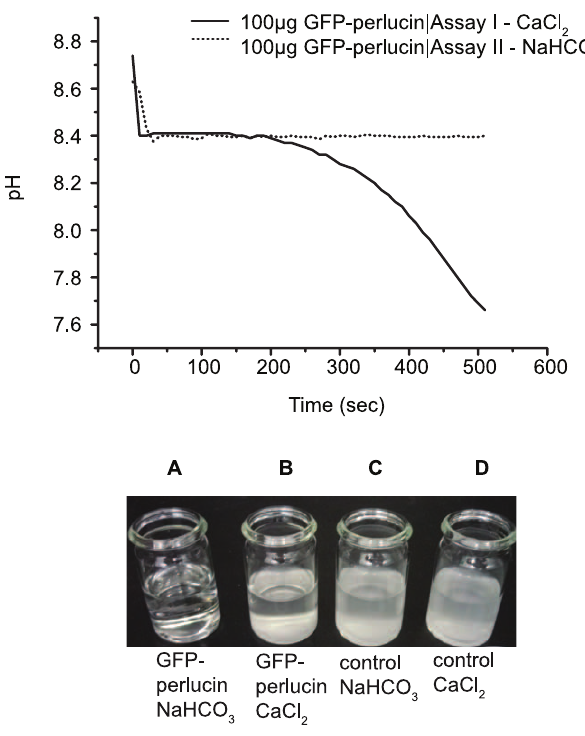
Figure 7. CaCO 3 precipitation assays I and II. The inhibitory effect of high protein concentrations on the precipitation of calcium carbonate depends on the initial protein precursor solution. The presence of 25–100 m g GFP or GFP-perlucin in a NaHCO 3 precursor solution delays the precipitation of calcium carbonate when Ca 2 + is added to this solution (top, dotted line; bottom, vial A). A protein/CaCl 2 precursor solution precipitates within , 10 min from the addition of HCO 3– as indicated by the pH curve (top, solid line) and yields a white precipitate (bottom, vial B). While the time-course of the pH drop observed in control experiments without protein additives is similar to the protein/CaCl 2 precursor, regardless of which one of the solutions is present in the vial and which one is added, the turbidity of the suspensions (bottom, vials C and D) differ from protein/CaCl 2 precursors (bottom, vial B). The changes of pH values during the initial time intervals of precipitation are summarized in Table 2.